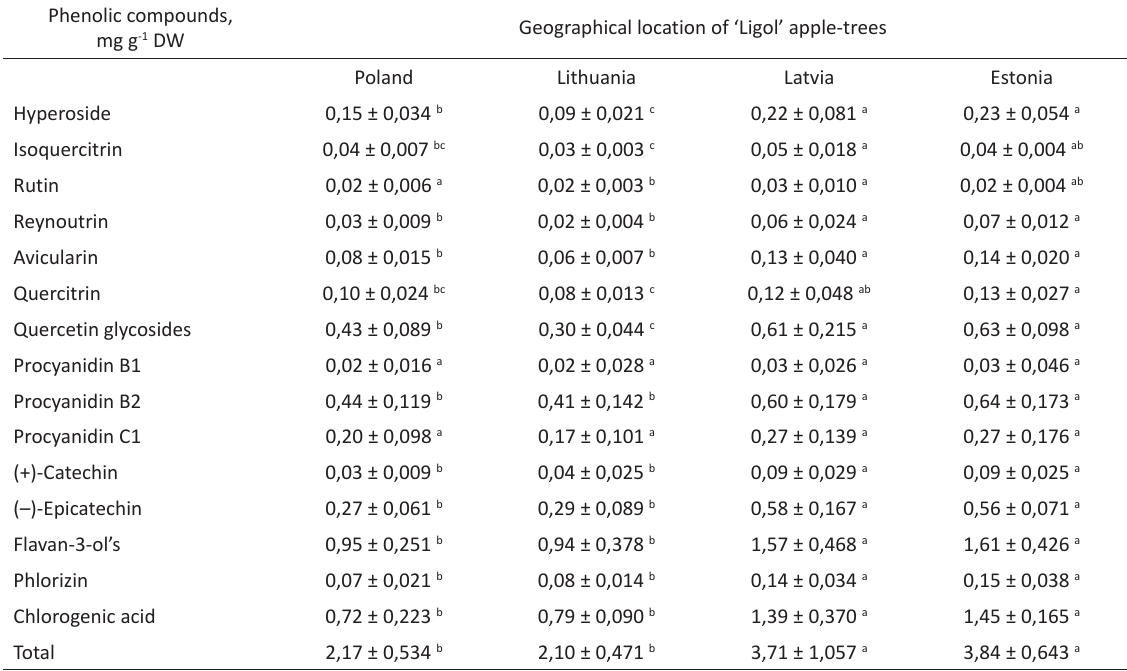
The different letters on the same line indicate statistically significant differences between the individual compounds in the apple samples ( p < 0.05). Table 3. Amount of investigated triterpene compounds (mg g -1 DW) in apple peel grown in different geographical locations (cv. ‘Auksis’, average 2016–2018) Triterpene compounds, mg g -1 DW